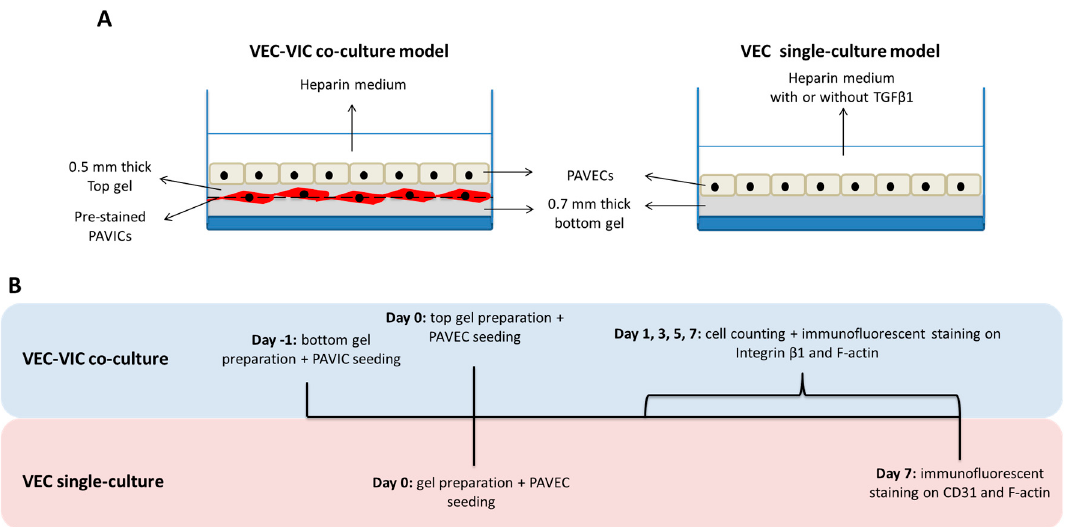
Figure 1. ( A ) Schematic of 3D valve endothelial cell (VEC)-valve interstitial cell (VIC) co-culture model and VEC single-culture model. ( B ) Experimental timeline of each 3D model.